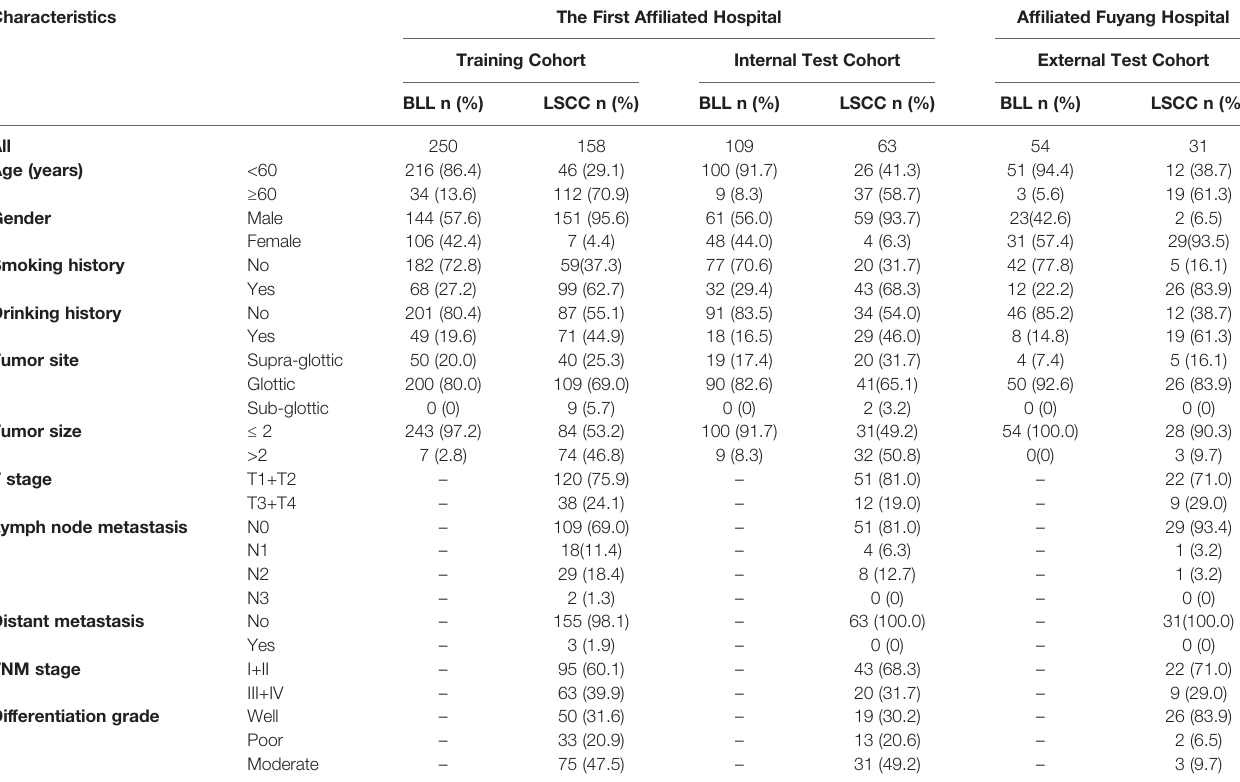
TABLE 1 | Patient demographics and clinicopathological characteristics. Characteristics